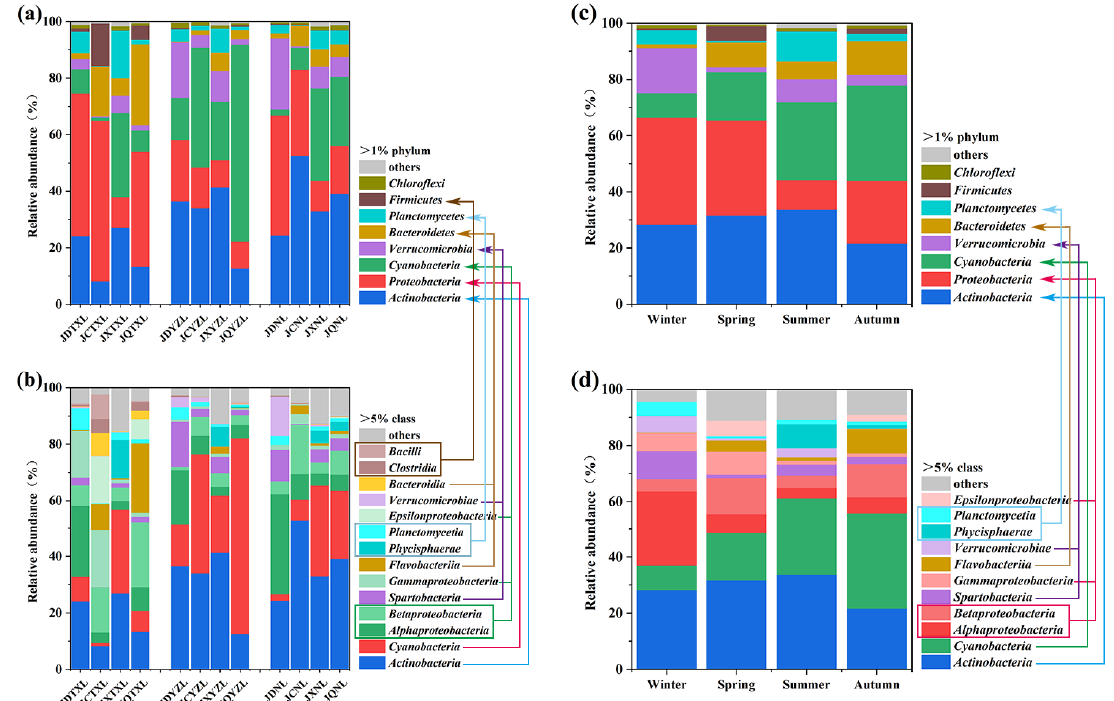
Figure 3. Bacterial community of each lake at phylum level ( a ) and class level ( b ); overall bacterial community of each season at phylum level ( c ) and class level ( d ). The water samples in spring, summer, autumn, and winter, respectively, are denoted as JCTXL, JXTXL, JQTXL and JDTXL for Tangxun Lake; JCYZL, JXYZL, JQYZL and JDYZL for Yezhi Lake and JCNL, JXNL, JQNL and JDNL for Nan Lake.